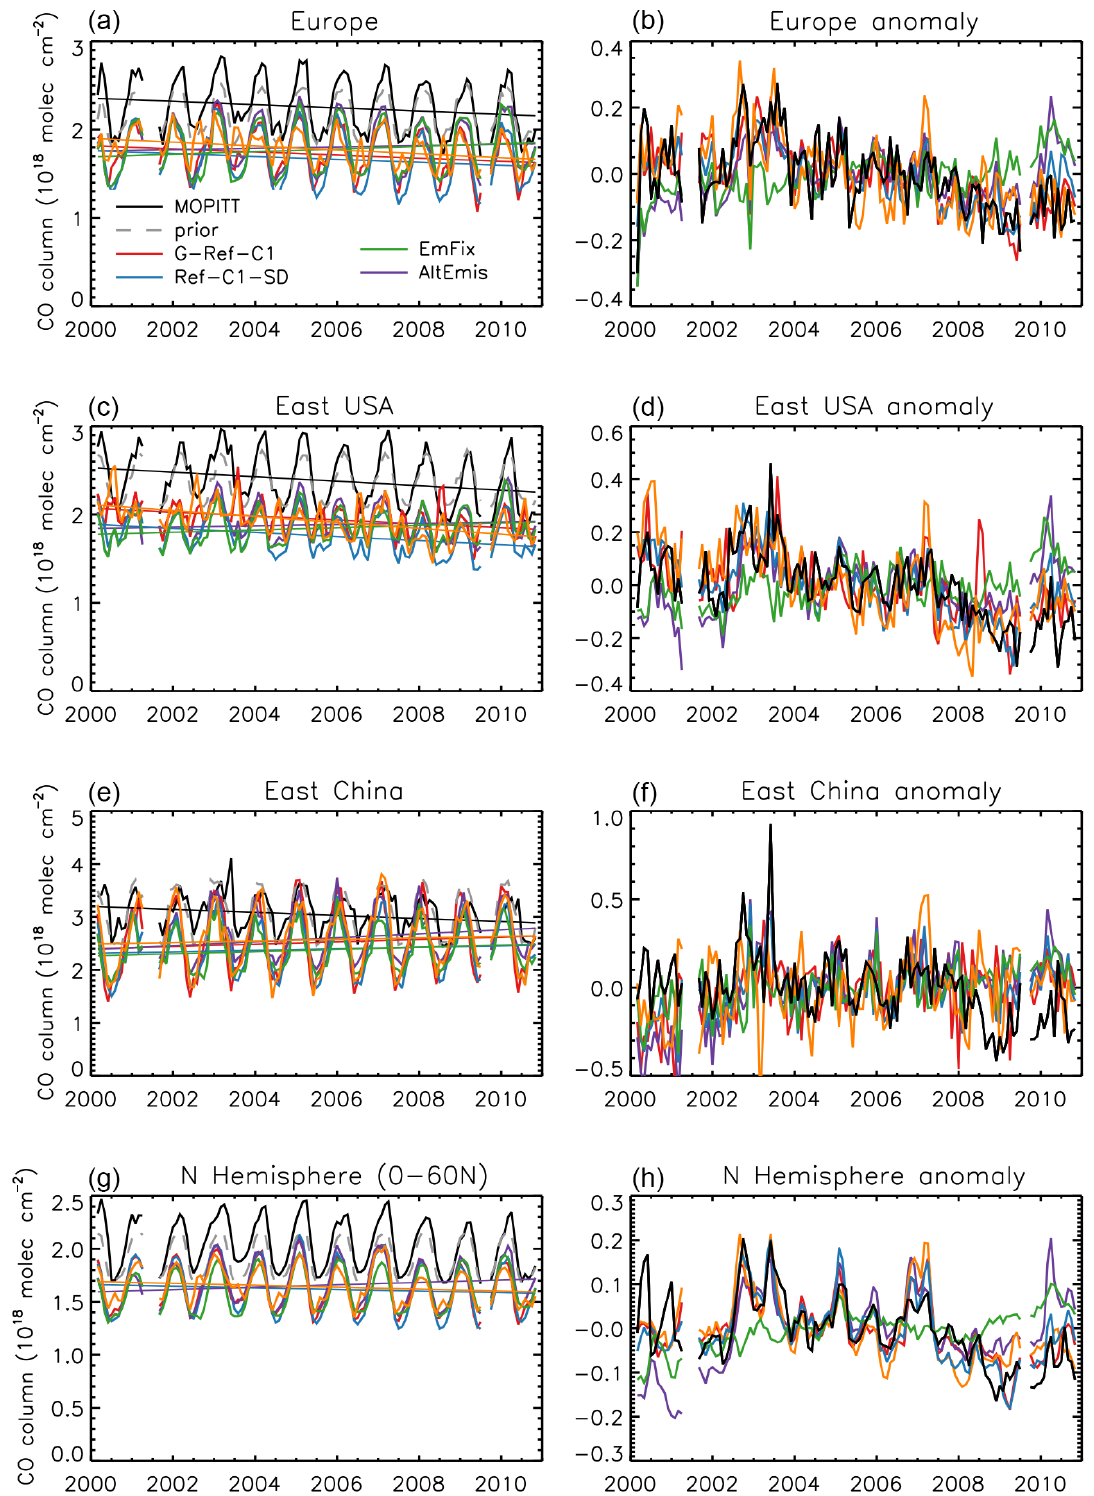
Figure 2. The time series and trends (left column) and deseasonalized monthly anomalies (right column) of the CO column from MOPITT (black), the MOPITT a priori (gray), and simulated by G-Ref-C1 (red), Ref-C1-SD (blue), EmFix (green), C-Ref-C1 (orange), and AltEmis (purple) for 2000–2010. The regions shown are (a, b) Europe (0–15 ◦ E, 45–55 ◦ N), (c, d) eastern United States (95–75 ◦ W, 35–40 ◦ N), (e, f) eastern China (110–123 ◦ E, 30–40 ◦ N), and (g, h) the Northern Hemisphere (0–60 ◦